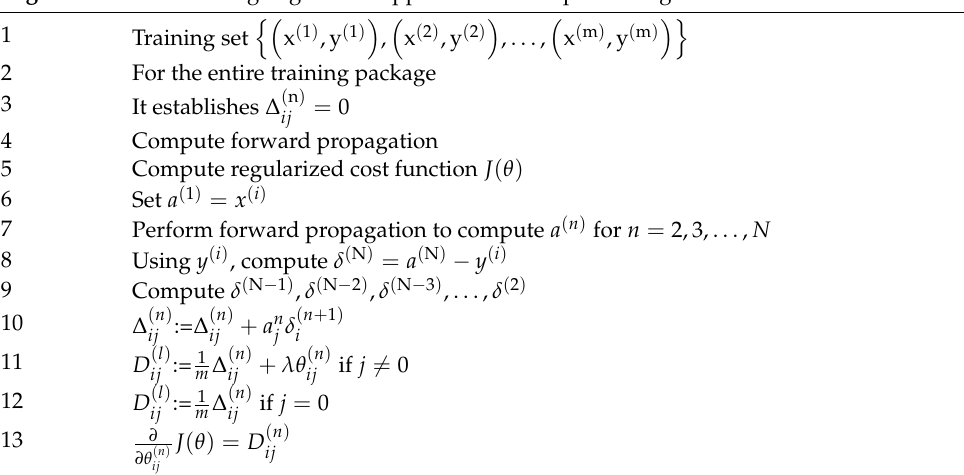
Algorithm 1 Backtracking Algorithm Applied in the Deep Learning